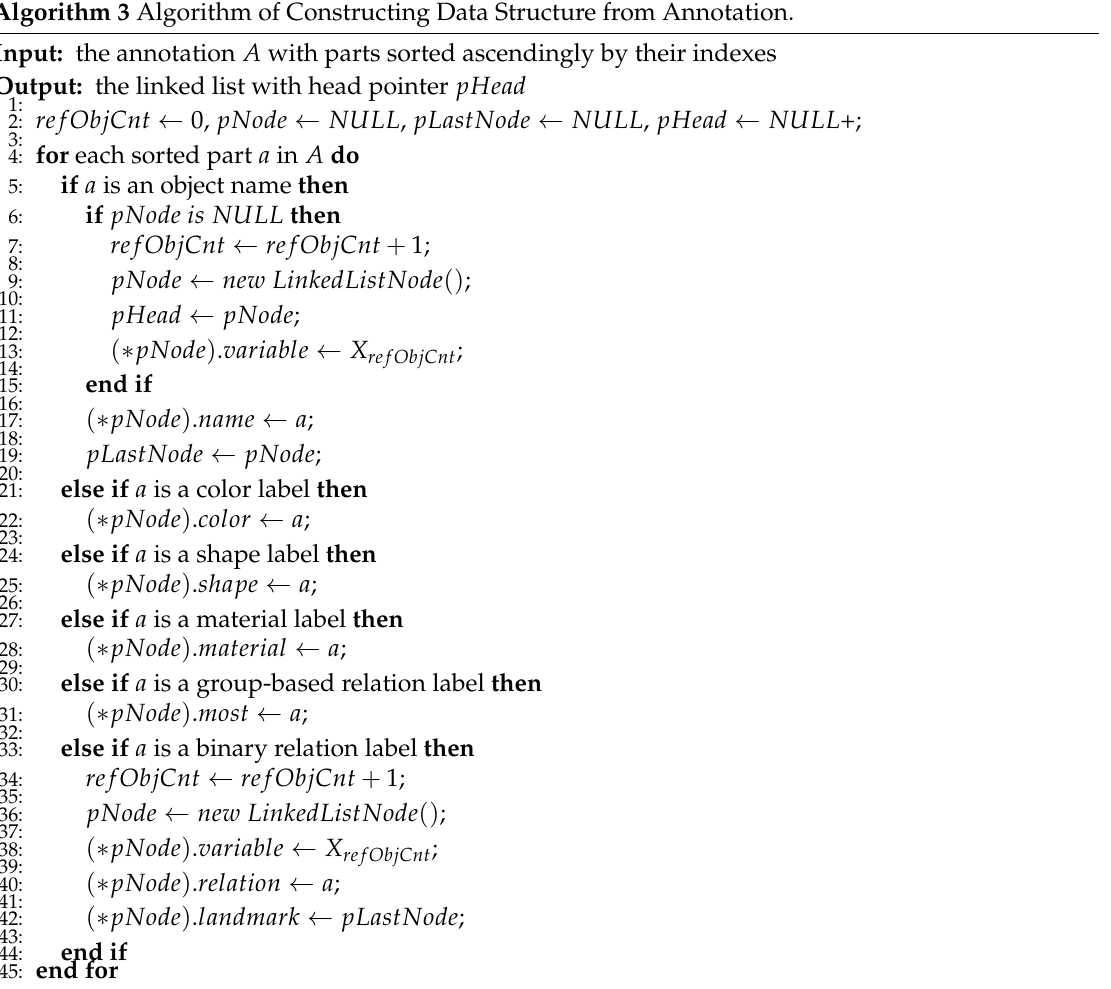
Algorithm 3 Algorithm of Constructing Data Structure from Annotation.